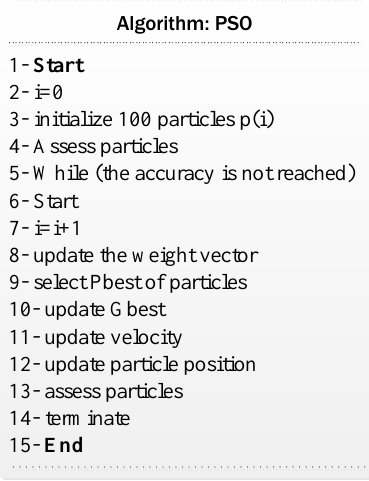
Figure 1. The Pseudo code of